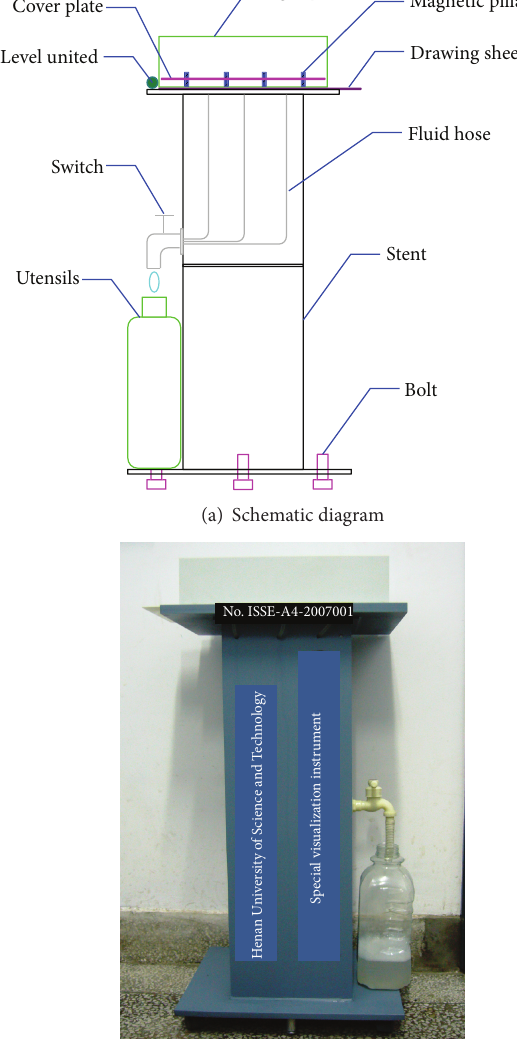
Figure 2: The shortest path experiment